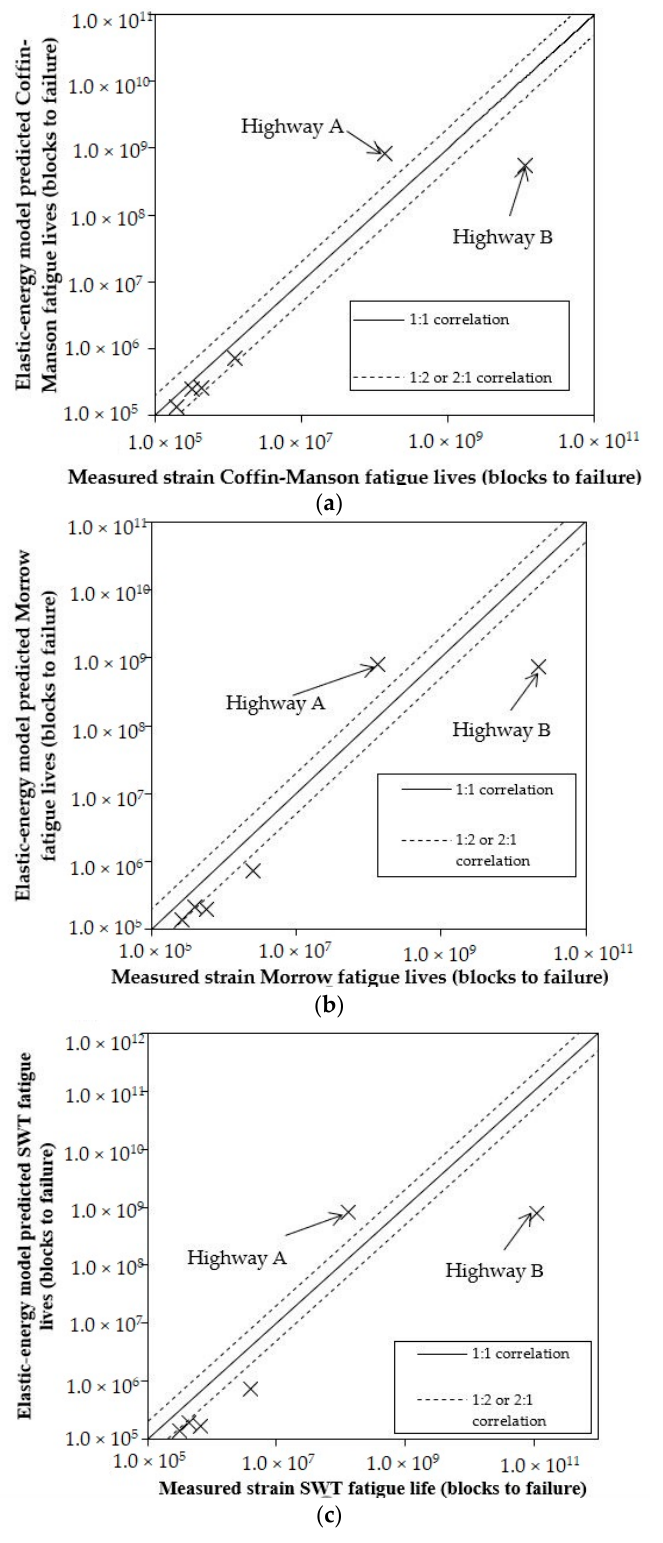
Figure 18. Scatter band for strain measurement and elastic-energy model fatigue life using various models: ( a ) Coffin-Manson, ( b ) Morrow, ( c ) Smith-Watson-Topper (SWT). To quantify the correlation between the elastic-energy model and measured strain predicted